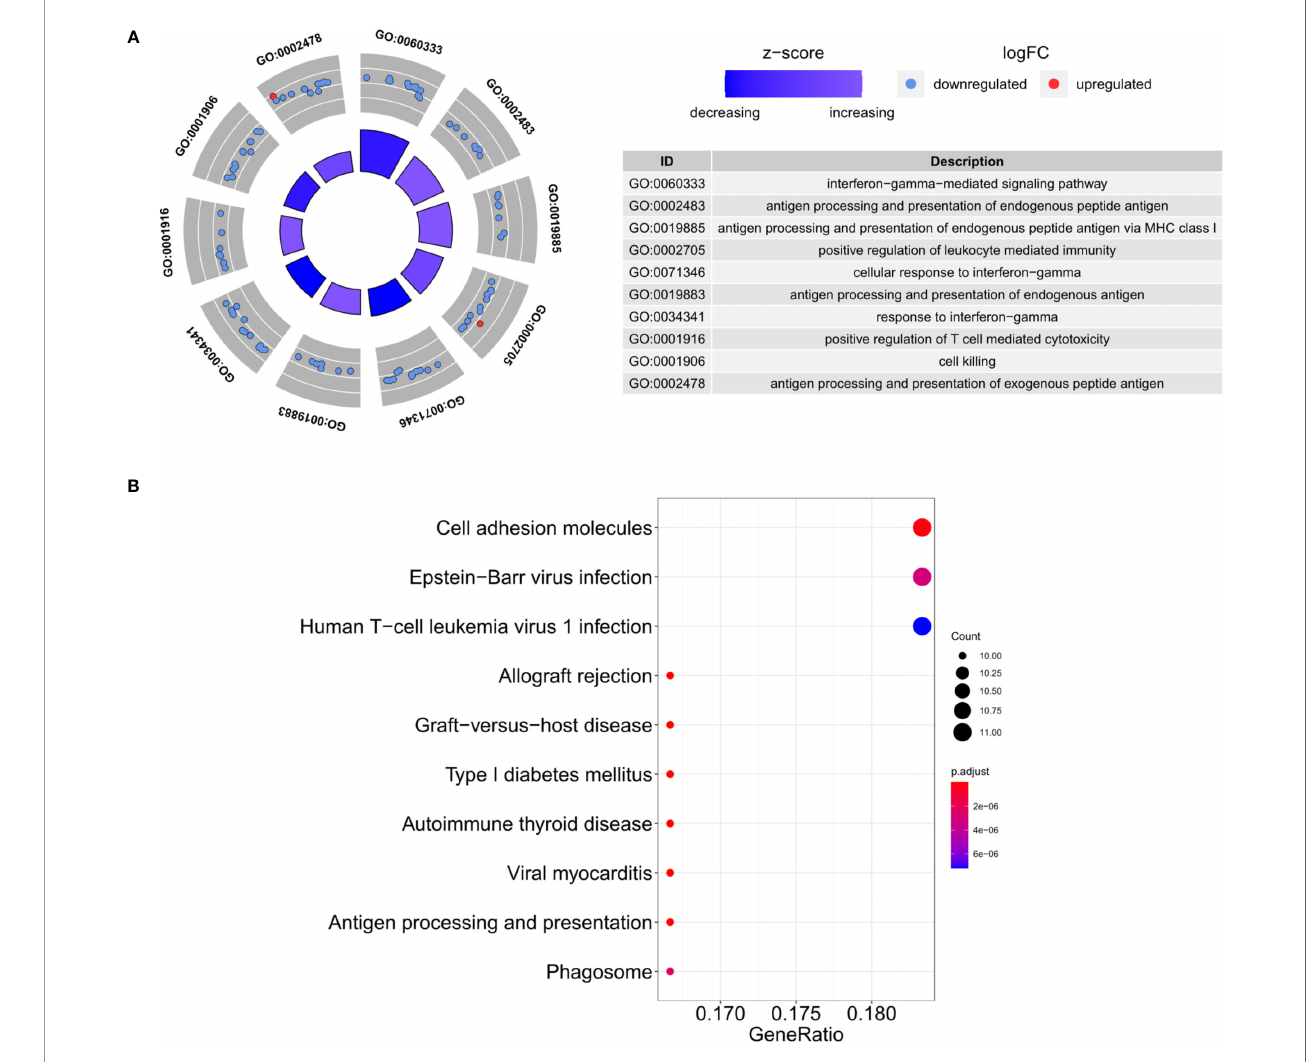
FIGURE 3 | Functional enrichment analysis. (A) The top 10 GO biological process categories. (B) The top 10 KEGG